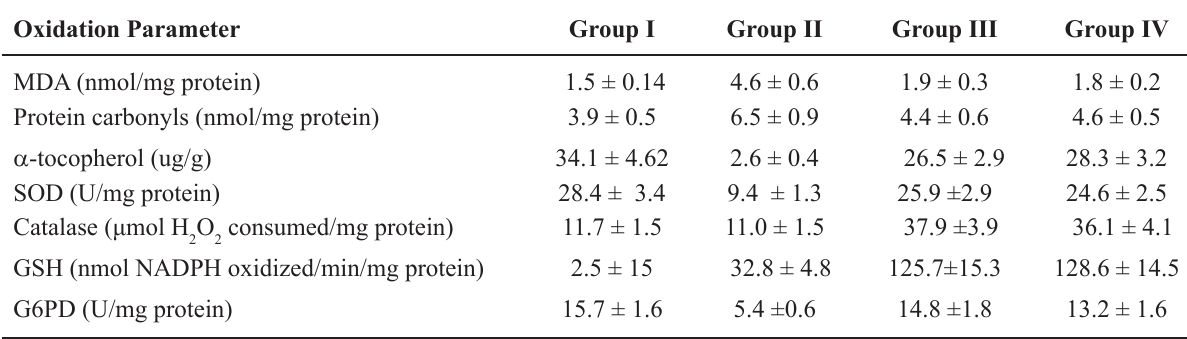
Table 4 – Lipid peroxidation and protein carbonyls in the kidneys of mice.